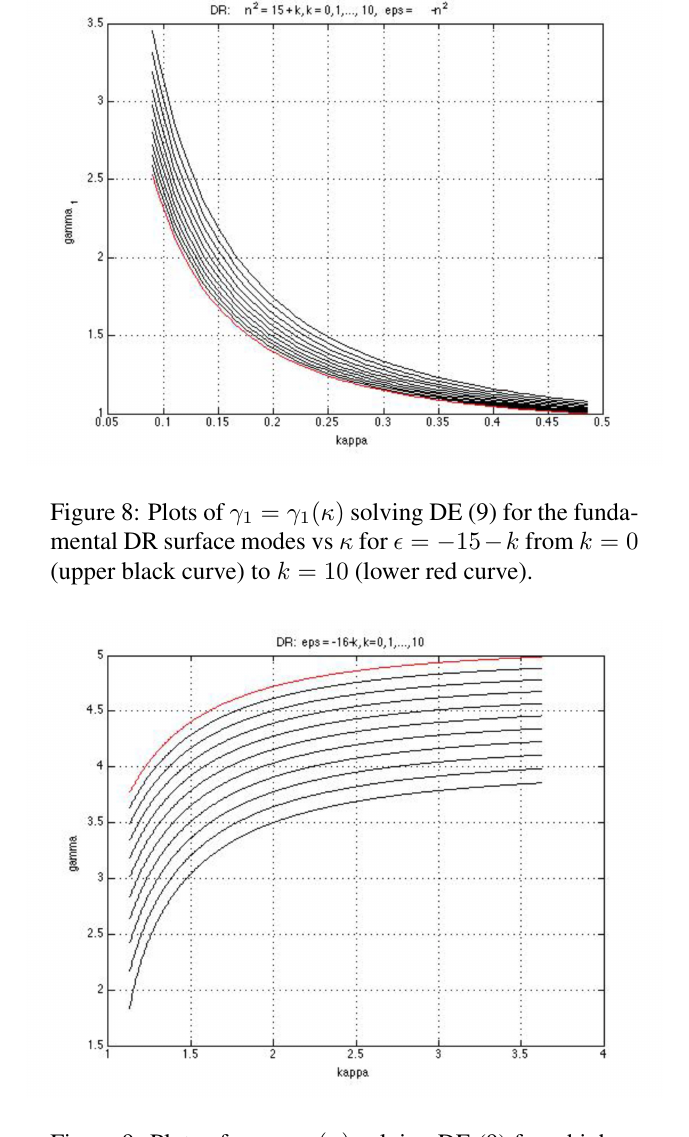
Figure 9: Plots of γ 2 = γ 2 ( κ ) solving DE (9) for a higher- order DR surface modes at (cid:15) = − 16 − k from k = 0 (lower black curve) to k = 10 (upper red curve) corresponding to smaller (left) intersection points of F d ( γ ) and G d ( γ ) in